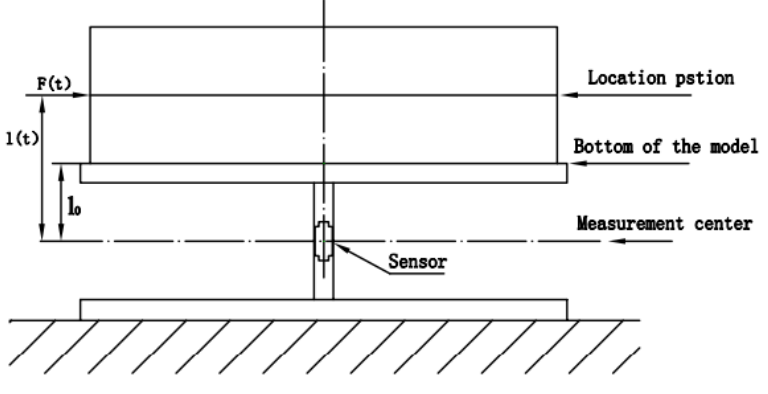
Figure 6. Correction of test data.